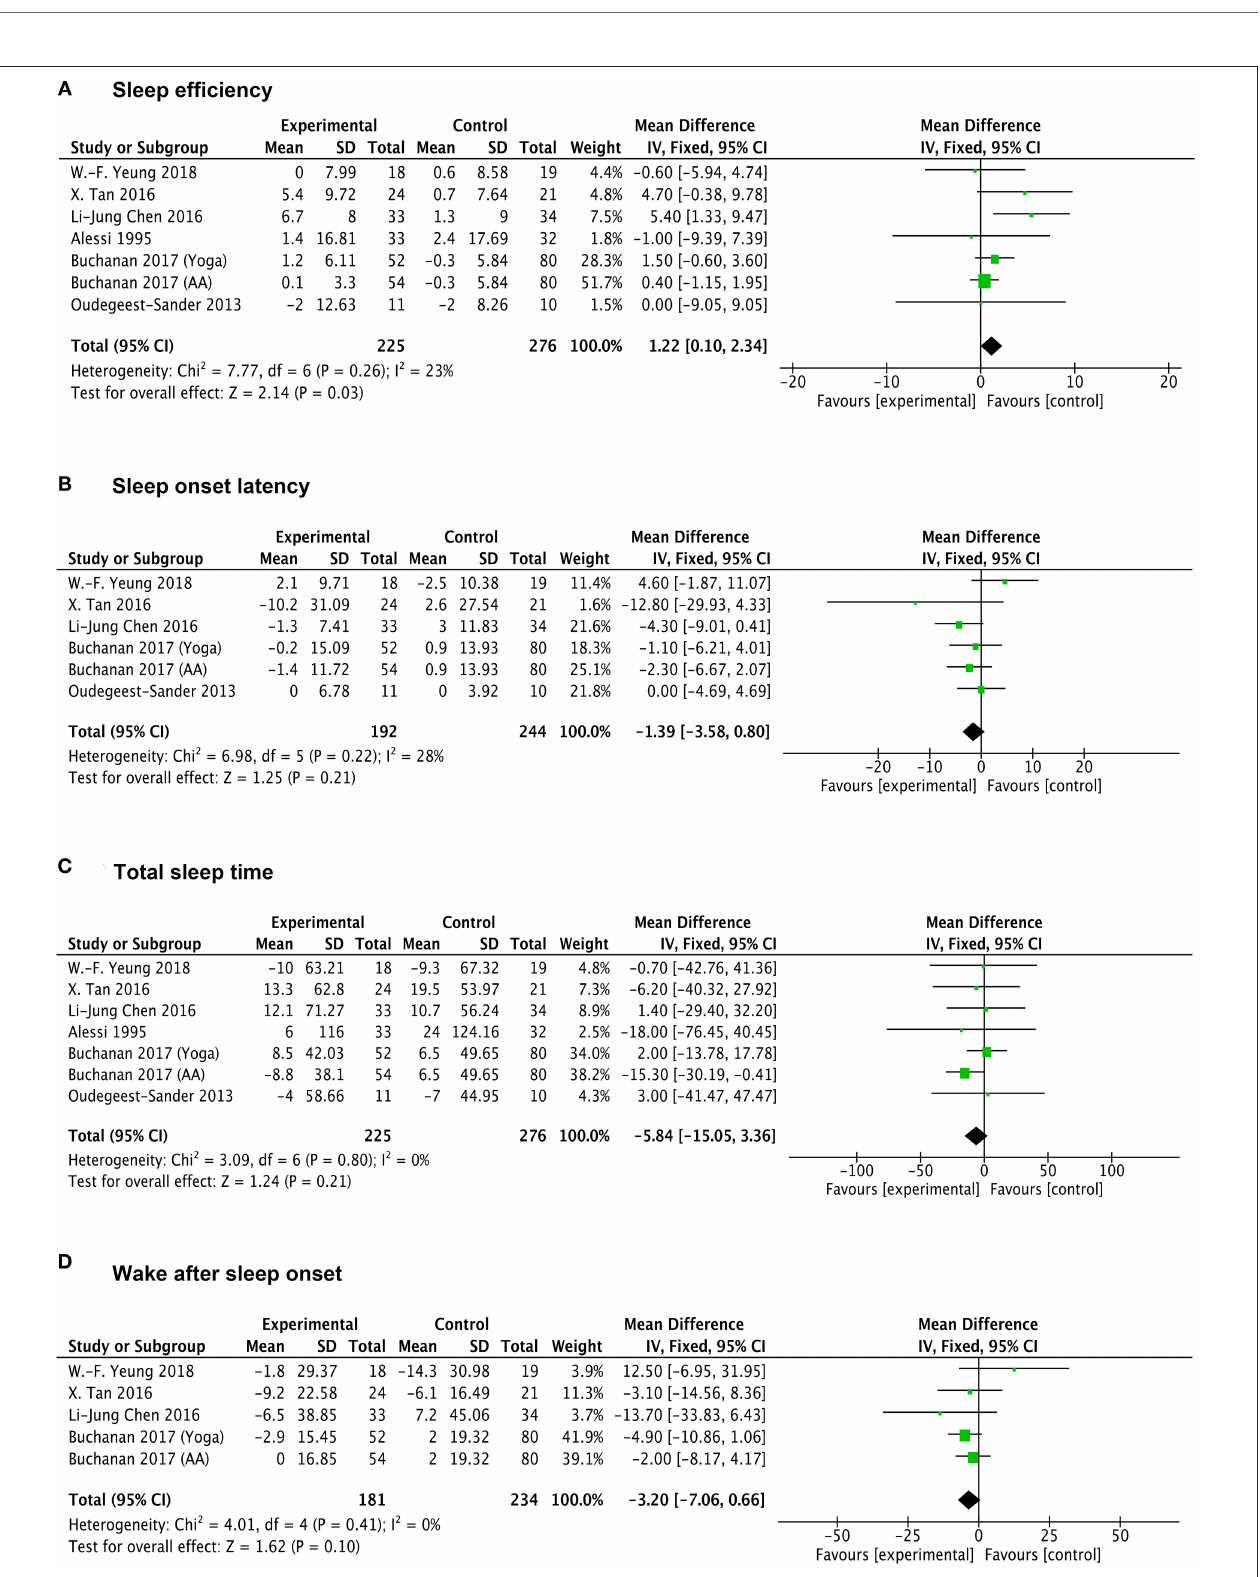
FIGURE 5 | Forests plot of Actigraph monitoring outcomes in overall analysis. (A) Forest plot of sleep efficiency outcomes. (B–D) Forest plot of sleep onset latency, total sleep time, wake after sleep onset, respectively.